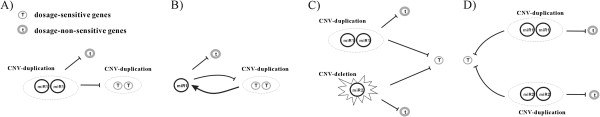
Schematic representation of the four paradigms used to explain co-evolution between CNVs and miRNAs. (A) A simple repression motif is involved where a miRNA reduces the expression of its target (T), the increased dosage due to CNV-duplication of the target (T) is balanced by the corresponding CNV-duplication of miRNA. (B) miRNA and its target (T) mutually buffer each other’s expression from perturbation in a negative feedback loop, the increased dosage due to CNV-duplication of the target (T) is buffered by the expression variation of the miRNA. (C) The CNV-duplication of some miRNAs compensate for the CNV-deletion of other miRNAs in balancing the dosage of their common target (T). (D) The common target (T) of two miRNAs is up-regulated in the cellular response to environmental factors; the intrinsic dosage-sensitivity of the target (T) makes the CNV-duplication of both the miRNA1 and miRNA2 become favorable. miRNA1 and miRNA2 represent two different miRNAs.